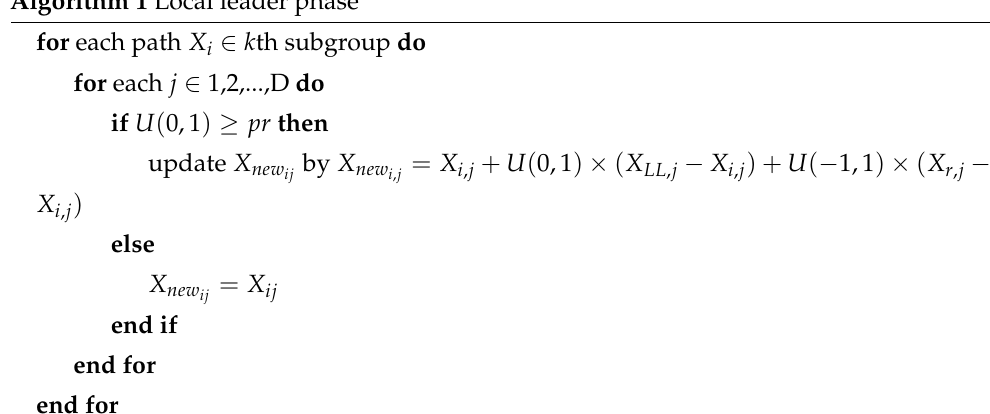
Algorithm 1 Local leader phase